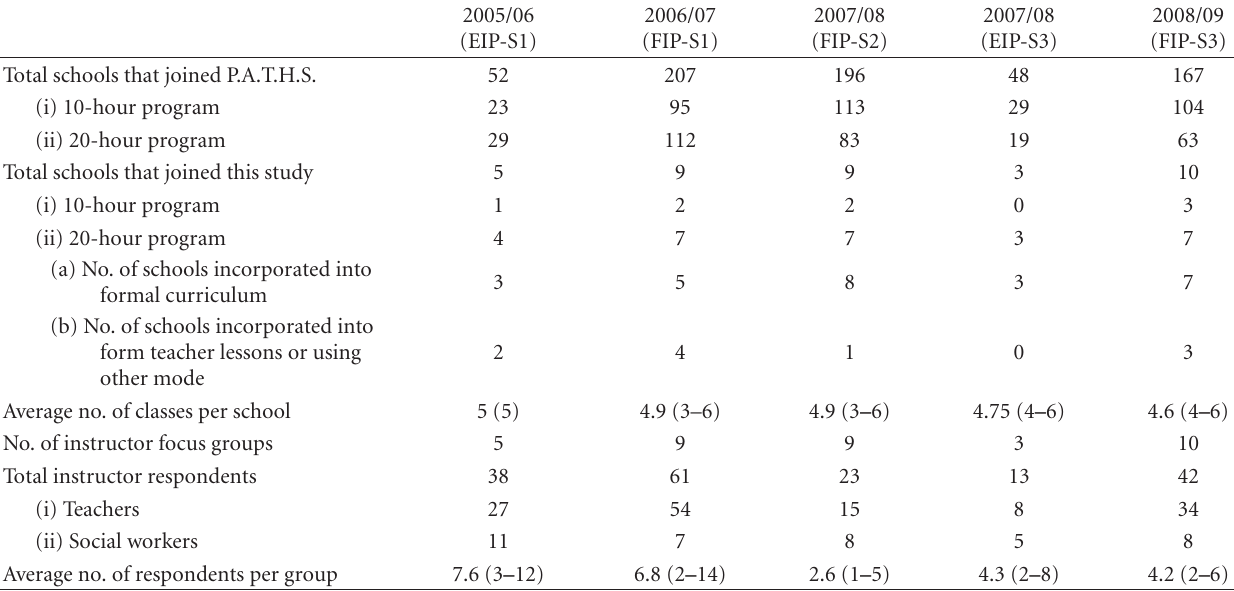
Table 1: Description of data characteristics from